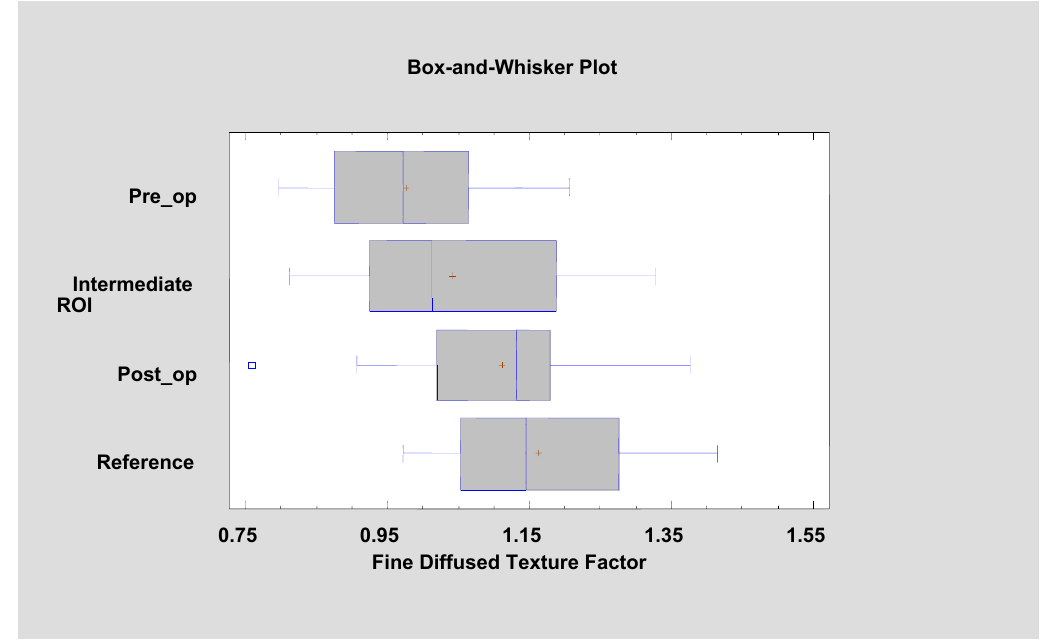
Figure 10. Factor 1 (fine diffused texture factor, FDT factor) calculated for the tested patients. It is noticeable that its value is approaching the mucosal reference value with the progress of leukoplakia treatment (ANOVA, F = 9.38, p <